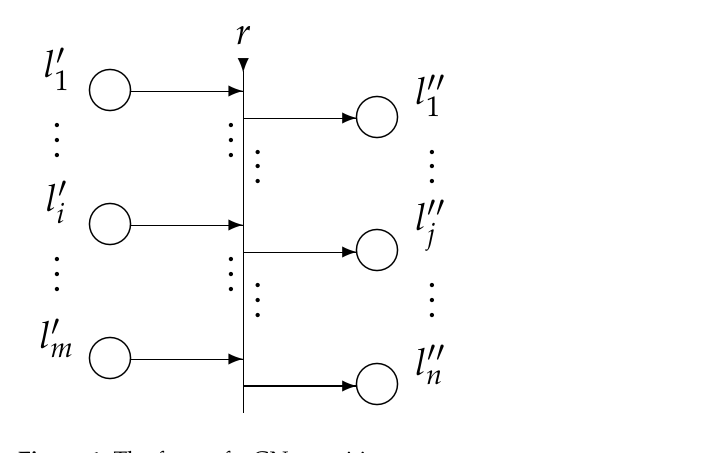
The form of a GN-transition Figure 1. The form of a Figure 1.